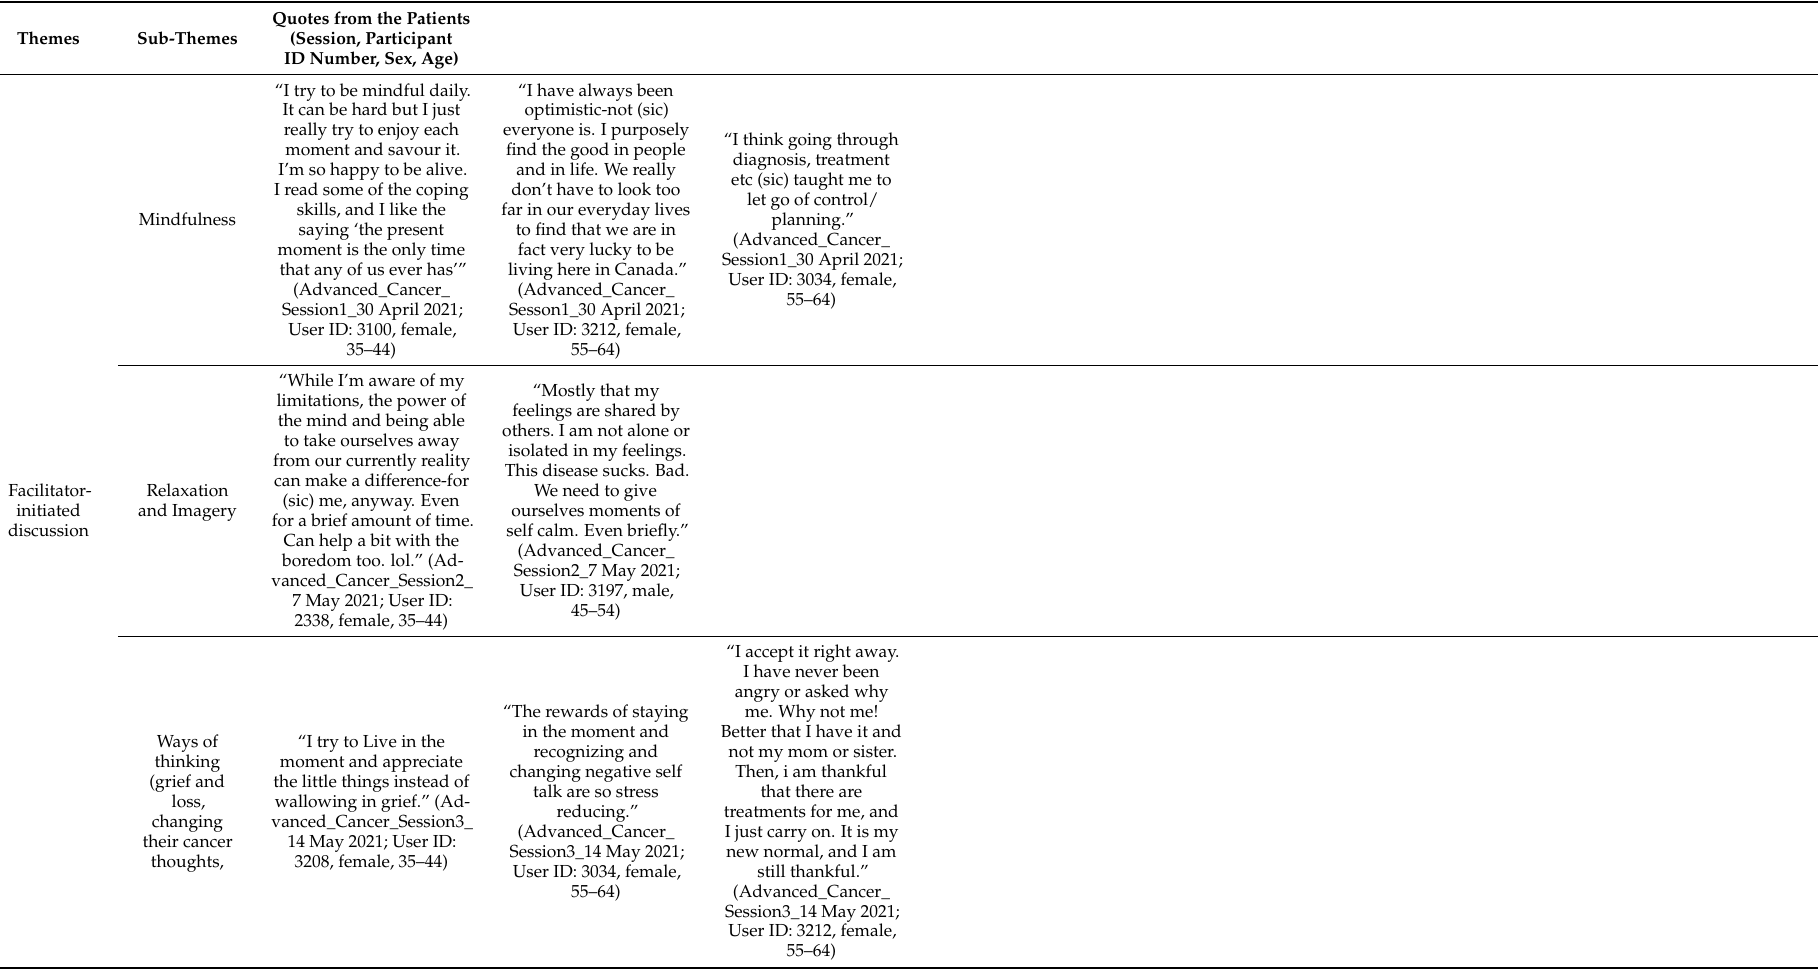
Table 2. Quotes from the Online Support Groups (OSG) indicating acceptance of participants, organized into themes and sub-themes. Quotes are labeled by session date, user ID, gender, and